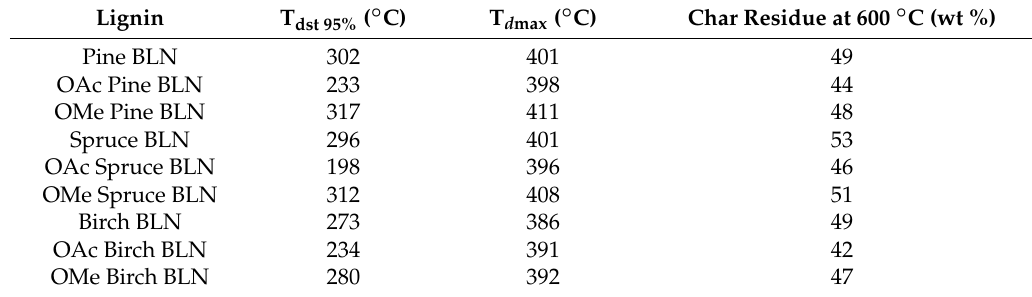
Figure 5. TG and DTG curves of ( a ) birch, ( b ) pine, and ( c ) spruce lignin and their acetylated and selectively methylated derivative. Table 4. Thermal properties of pine, spruce, and birch lignin and their acetylated and methylated derivatives.